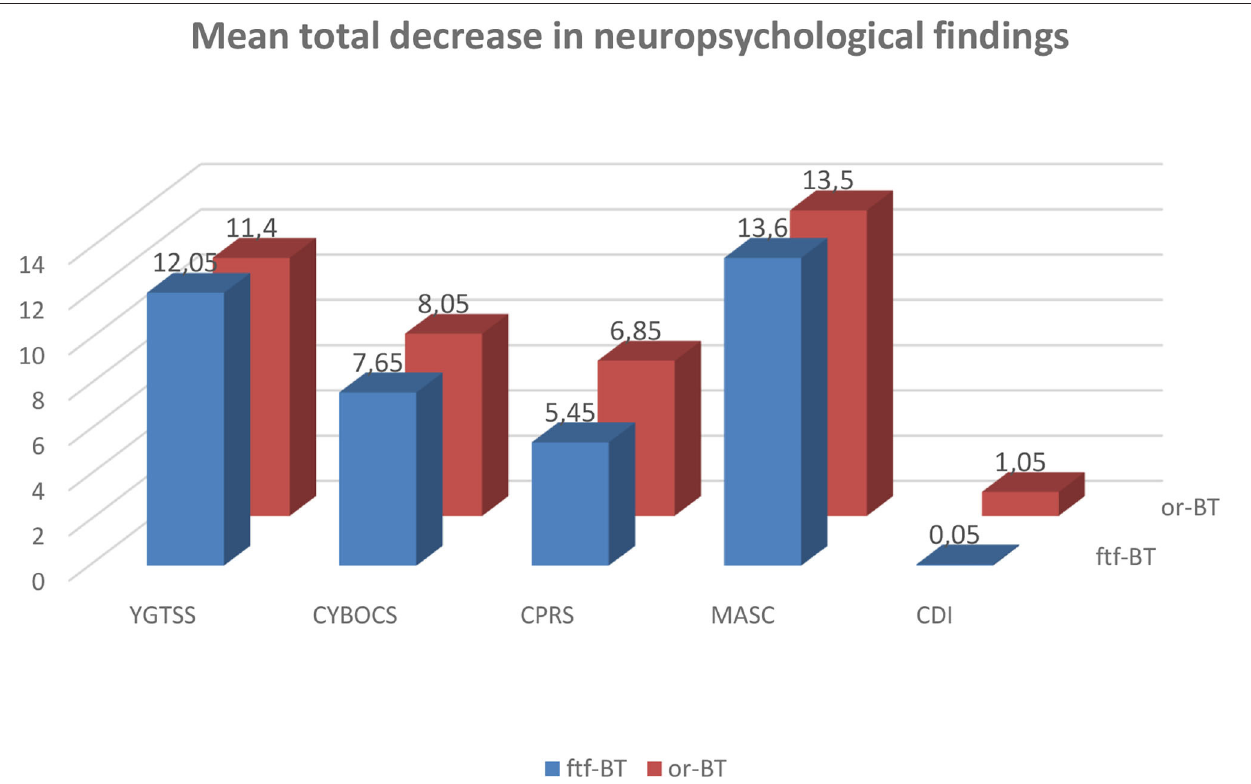
FIGURE 1 | Mean total decrease in neuropsychological findings between T0 and T1.